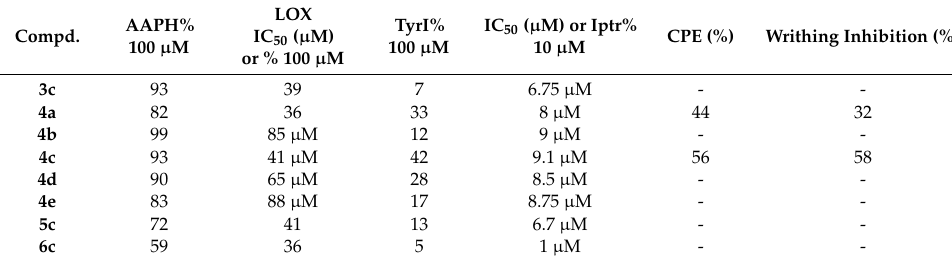
Table 5. Biological activities of the most potent